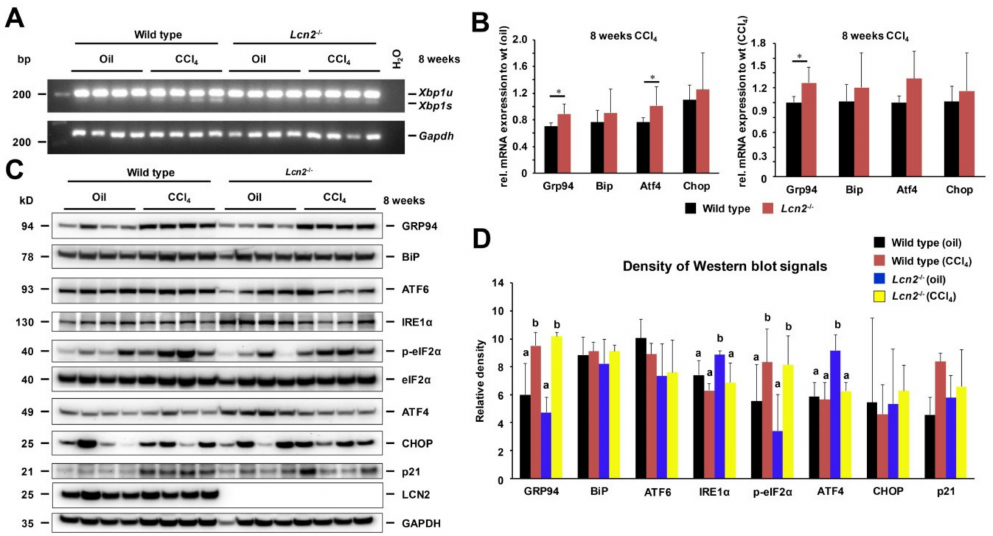
Figure 1. Long-term repeated CCl 4 intoxication induced endoplasmic reticulum (ER) stress and unfolded protein responses (UPR). ( A ) Semi-quantitative PCR showed Xbp1s in CCl 4 -treated livers of wild type and Lcn2 − / − mice. ( B ) Real-time quantitative polymerase chain reaction (RT-qPCR) showing the ER stress-markers Grp94 , Bip , Atf4 , and Chop mRNA in relation to oil- (left panel) or CCl 4 -treated wild type mice (right panel). Lcn2 − / − mice showed relative higher values compared to the wild type. ( C ) Western blot analysis showing increased GRP94, BiP, p-eIF2 α , and p21 in CCl 4 -treated mice, while showing lower levels of ATF6, IRE1 α , and ATF4 in CCl 4 -treated Lcn2 − / − mice. CHOP levels fluctuate between animals. ( D ) Graph depicting Western blot quantifications. Details about the statistics are given in Supplementary Table